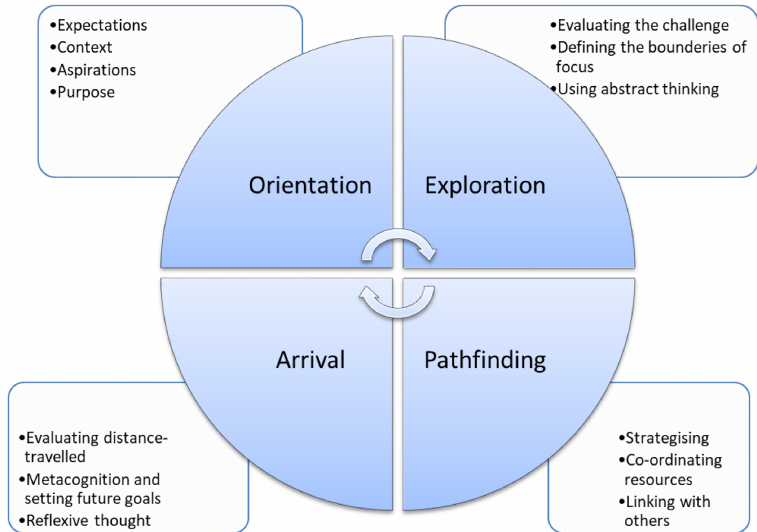
Figure 2. Mapping the formal heutagogic learning